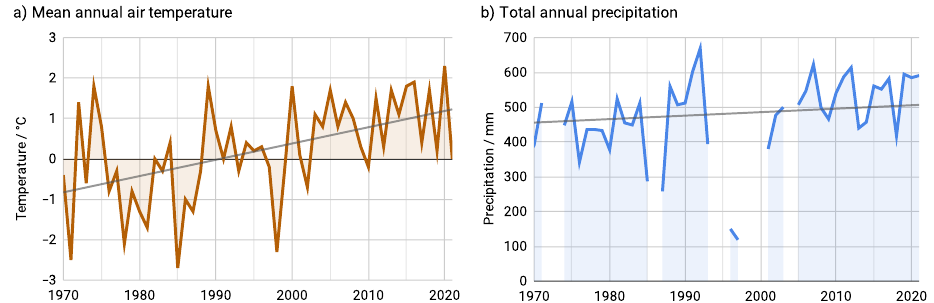
Figure 3. ( a ) Mean annual air temperature at 2 m above ground, ( b ) total annual precipitation and their trend lines acquired at the meteo station Monchegorsk (ID 22212) [27]. The date range spans back beyond 1985 to illustrate that the observed trends in temperature and precipitation have a long-term nature. Gaps in the precipitation time series correspond to years with partially missing